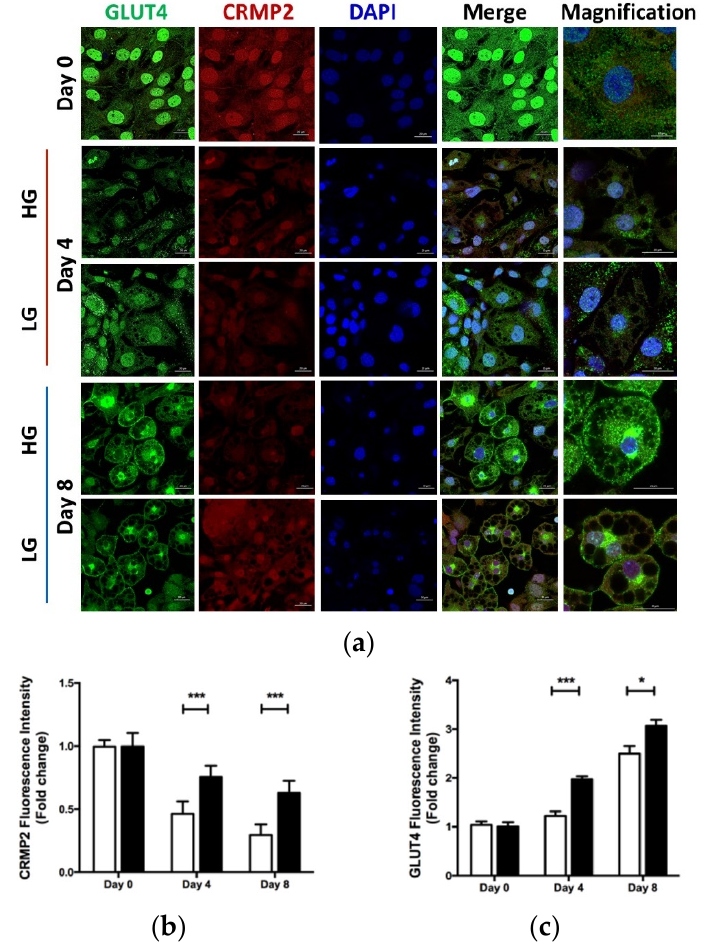
Figure 6. Effect of glucose on CRMP2 and GLUT4 profile. Cells were induced into differentiation in culture media containing either high (450 mg/dL, HG) or low glucose (100 mg/dL, LG). ( a ) CRMP2 and GLUT4 were detected by immunofluorescence at the indicated time. Quantitative results of CRMP2 ( b ) and GLUT4 ( c ) fluorescence intensity from (a). Images were captured using a Zeiss LSM 880 laser confocal microscope, and scale bars represent 20 μ m or 10 μ m (magnification). Data are presented as means ± SEM of about 50 cells in each group from 3 independent experiments. * p < 0.05, *** p < 0.005 vs. HG.